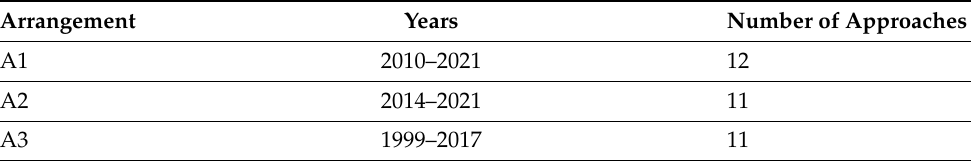
Table 1. Approaches using circles with three arrangements Arrangement Years Number of